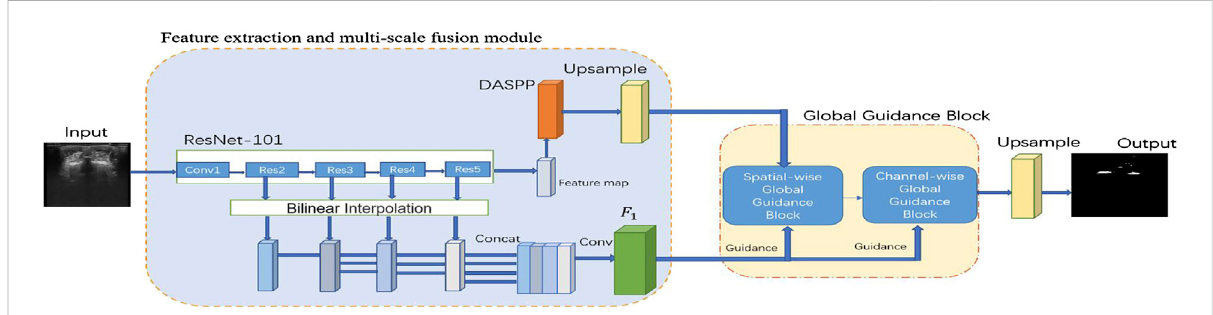
FIGURE 1 SchematicillustrationoftheproposedspinalultrasoundimagesegmentationnetworkcalledUGBNet.ResNet-101isusedtoextractdenselocal